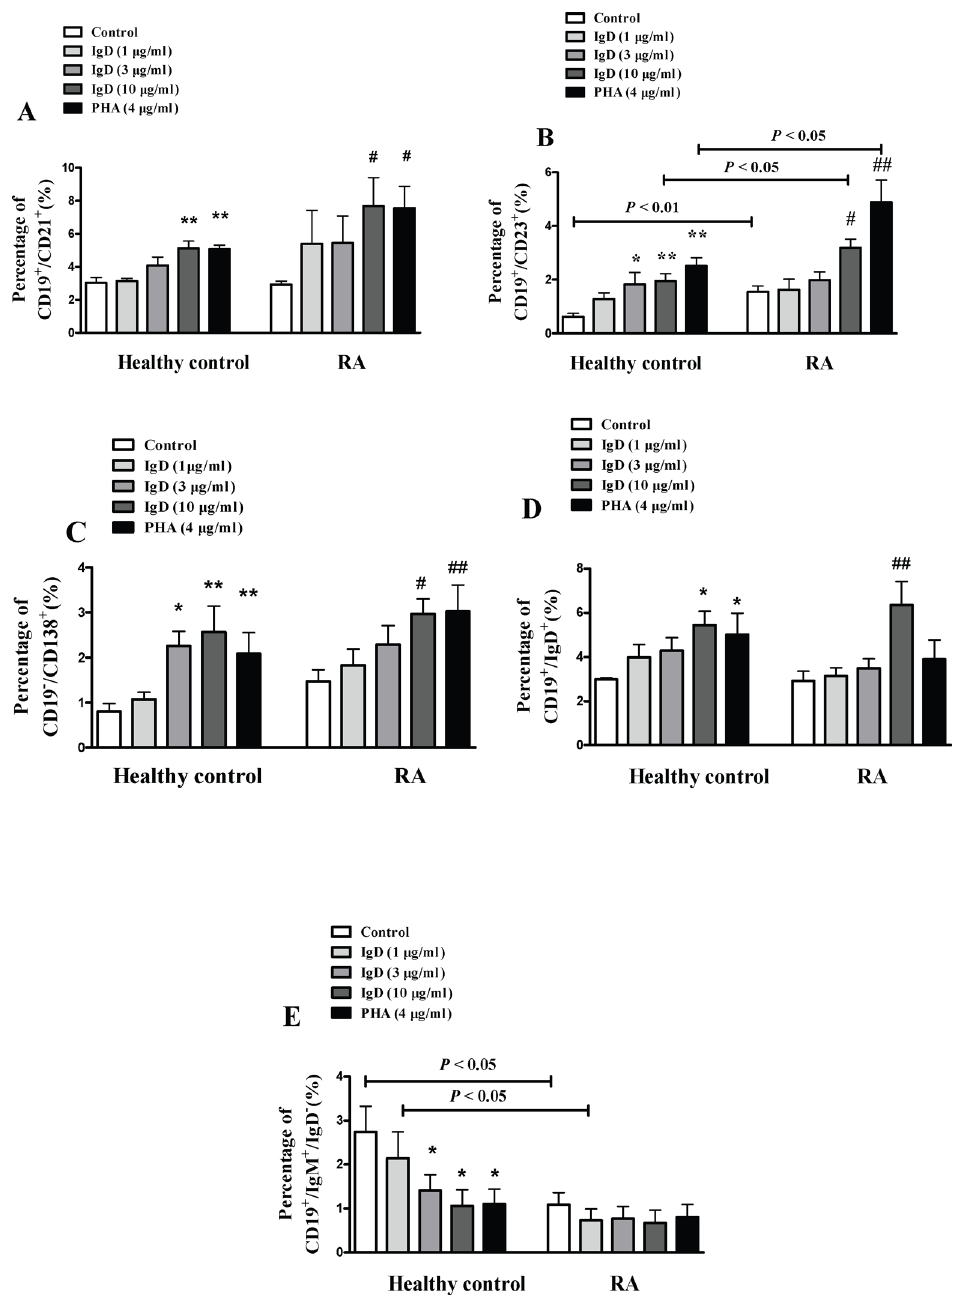
Fig 7. The effects of IgD on subsets of B cells in PBMCs from RA patients and healthy controls. Flow cytometry analysis was used to analyze the effects of IgD (1, 3, or 10 μ g/ml) or PHA (4 μ g/ml) on the percentages of activated B cells (CD19 + CD23 + , CD19 + CD21 + ), mature B cells (CD19 + IgD + ), plasma cells (CD19 - CD138 + ), and immature B cells (CD19 + IgM + IgD - ). Data are expressed as the mean ± standard error of the mean (n = 8). * P < 0.05, ** P < 0.01 vs . the control from healthy controls; # P < 0.05, ## P < 0.01 vs . the control from